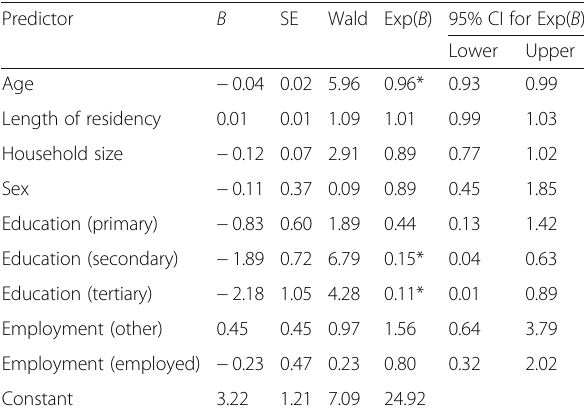
Table 3 Logistic regression model for factors influencing household forest dependency